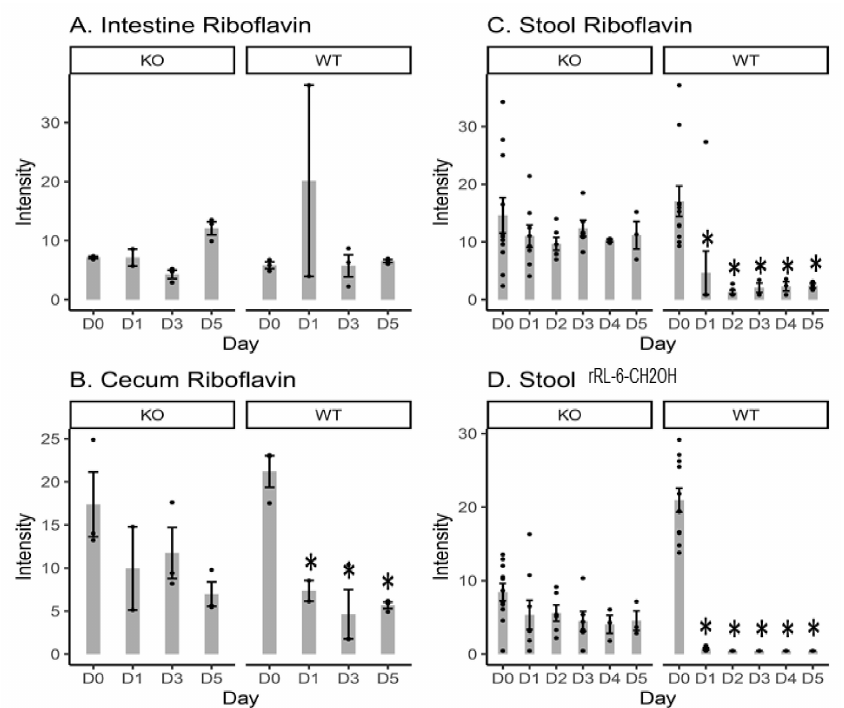
Figure 1. Bar plots of the intensity levels of riboflavin detected in the intestinal content ( A ), cecal content ( B ), and stool samples ( C ); and the intensity levels of 6-hydroxymethyl-8-D-ribityllumazine (rRL-6-CH 2 OH; a major histocompatibility complex class I-related molecule (MR1)-restricted riboflavin derivative) in the stool samples ( D ) from knockout (KO) and wild-type (WT) mice. D0 = day 0 (prior to Cef treatment); D1, D2, D3, D4 and D5 = 1, 2, 3, 4, or 5 days after Cef treatment, respectively; * = significant changes at p < 0.05; • = intensity data from each individual